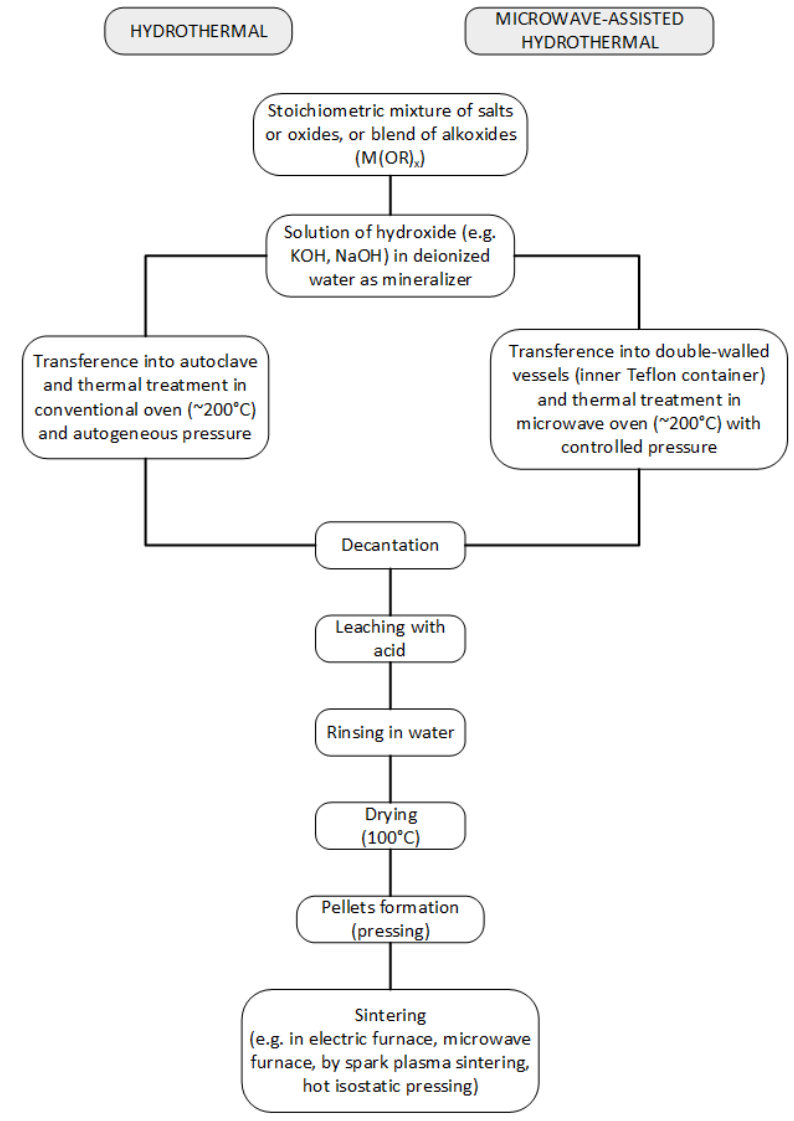
Figure 5. Flux diagram for hydrothermal and microwave assisted hydrothermal synthesis methods.